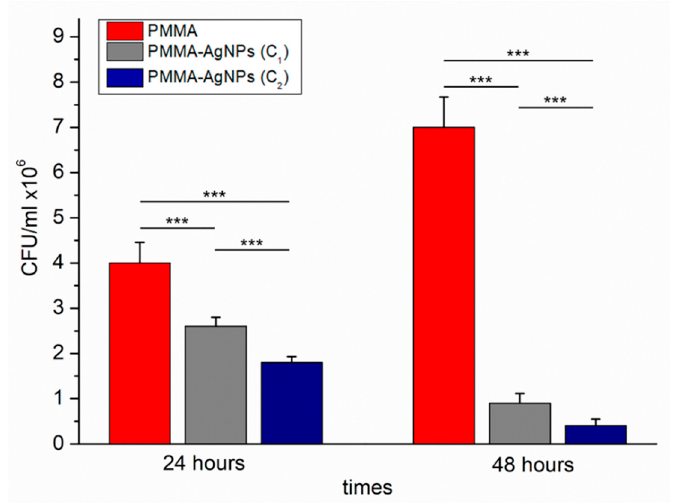
Figure 5. Viability of C. albicans on PMMA–AgNPs C1 (3 wt%) and PMMA–AgNPs C2 (3.5 wt%) were assessed by colony forming units (CFU) counts (the Miles and Misra test) after 24 h and 48 h of incubation. PMMA without AgNPs were also included as negative control. Data reported were calculated as average ± SD on three independent experiments, and the statistical significance respect to the control was represented (*** p -value < 0.005).